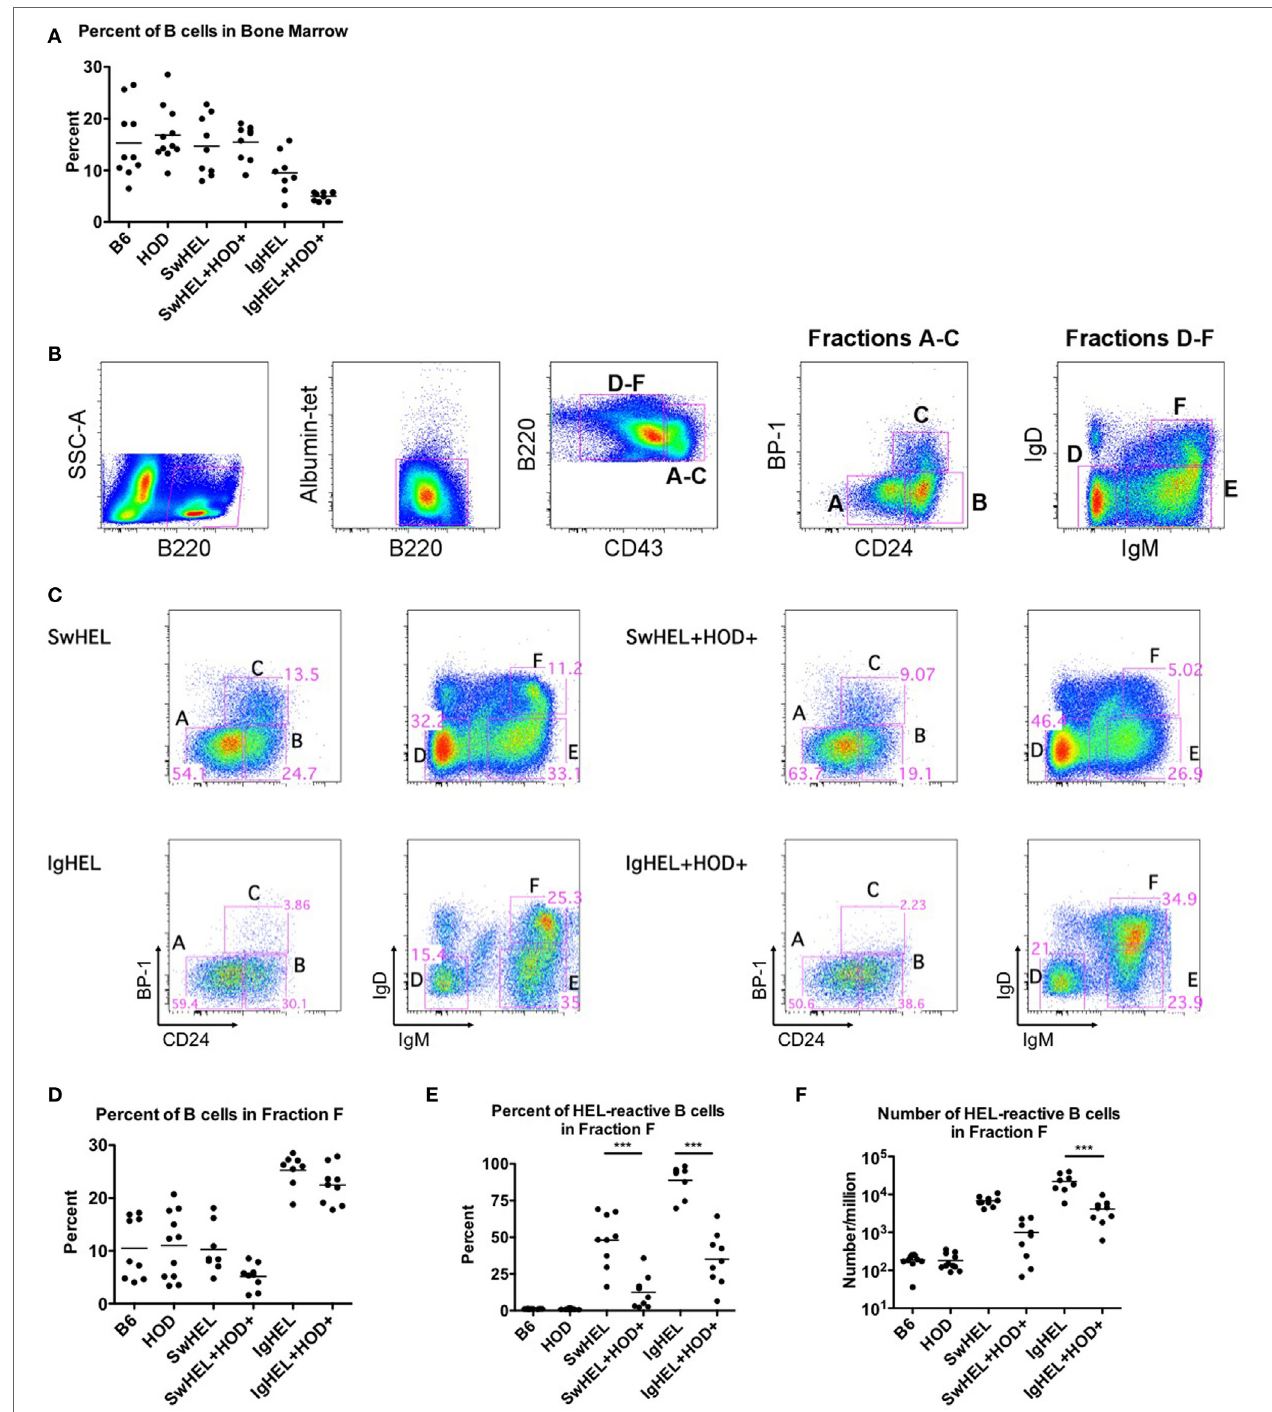
FigUre 2 | Effect of red blood cell (RBC) autoantigen on B cell development in bone marrow. Bone marrow was harvested, RBCs were lysed, and residual cells were stained with anti-B220, anti-CD43, anti-CD24, anti-IgD, anti-IgM, anti-BP-1, HEL-tet, and control Albumin-tet to delineate the stages of bone marrow development. (a) The percentage of B cells in bone marrow was determined for each indicated genotype. (B) Bone marrow cells were evaluated for cell surface markers to determine the stages of B cell development, and (c) Fractions A–F are shown for each indicated genotype. (D) The percent of total B cells, and (e) percent and (F) number of hen egg lysozyme (HEL)-reactive B cells were determined for Fraction F, the final stage of bone marrow development. Flow plots are representative data from three independent experiments with at least three mice per group. Scatter dot plots in (a,D–F) are compiled data from three independent experiments with at least three mice per group. Selective p values are shown on graphs and * ≤ 0.05, ** ≤ 0.01, and *** ≤ 0.001. For complete statistical analysis with all significant differences, see Table S2 in Supplementary